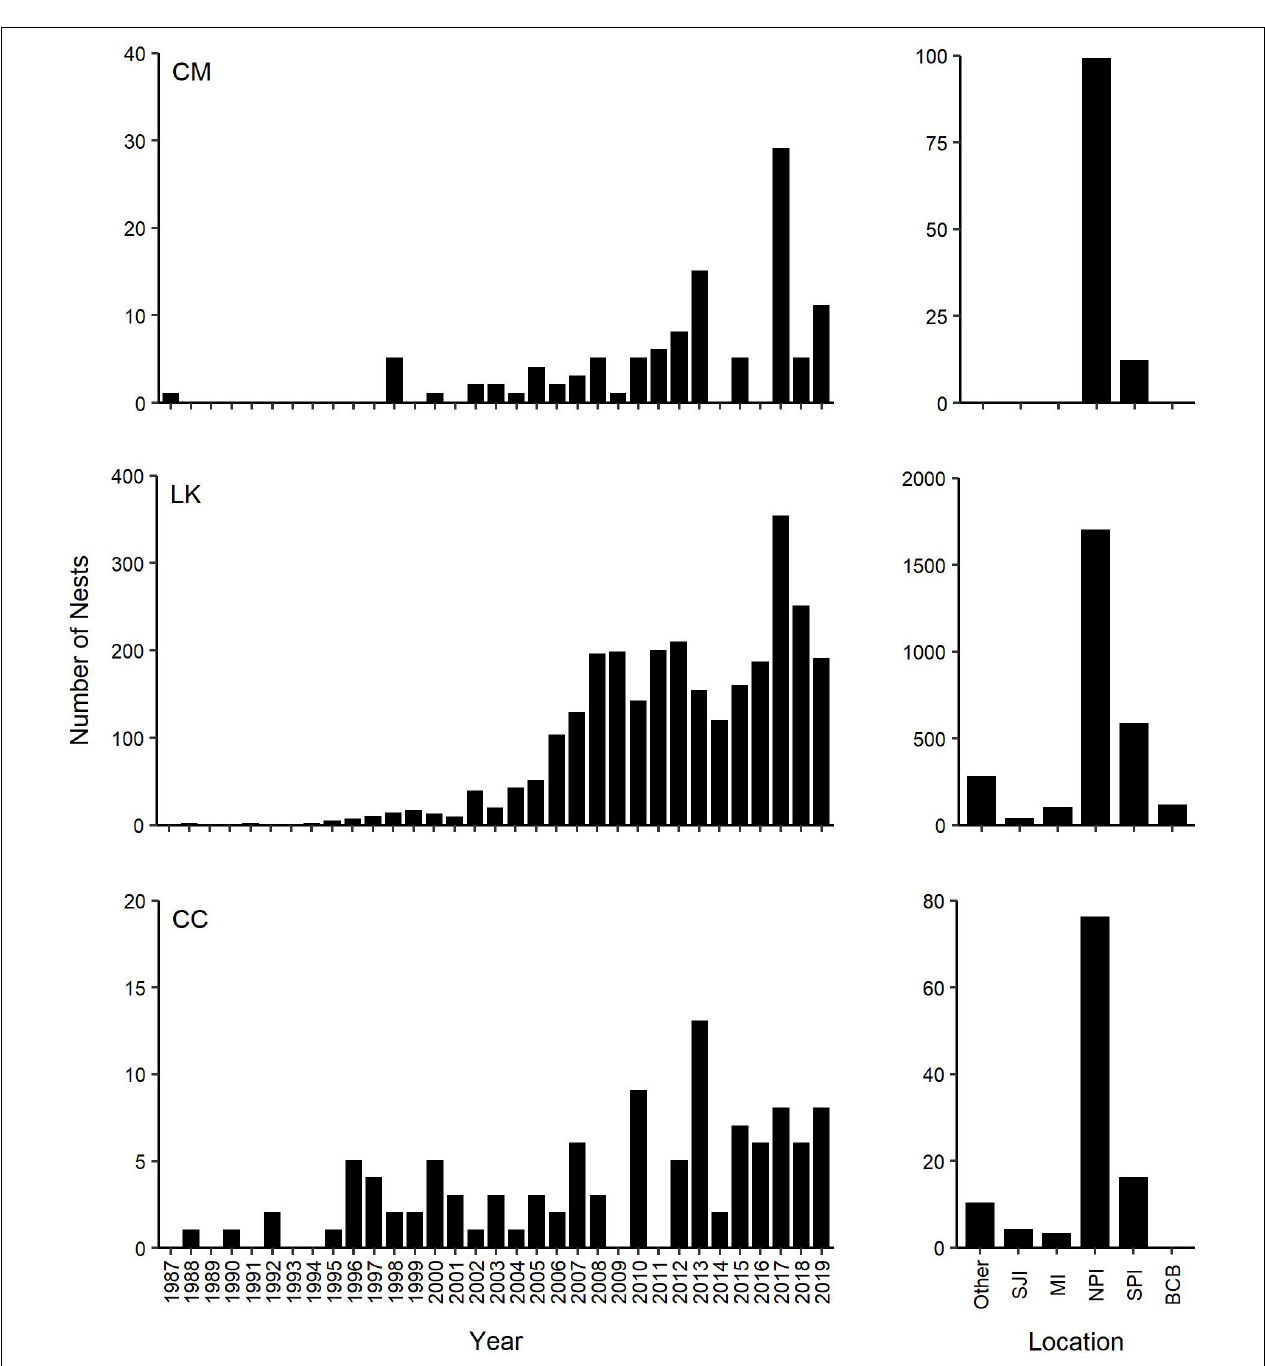
FIGURE 5 | Nesting trends of green (CM, Chelonia mydas ), Kemp’s ridley (LK, Lepidochelys kempii ), and loggerhead (CC, Caretta caretta ) turtles in Texas, United States between 1987 and 2019, with total documented nests each year and total numbers of nests documented on specific Texas beaches. Other: All other Texas beaches where green turtle nesting activity has not been observed that are monitored annually for nesting activity; SJI, San Jose Island; MI, Mustang Island; NPI, North Padre Island; SPI, South Padre Island; BCB, Boca Chica